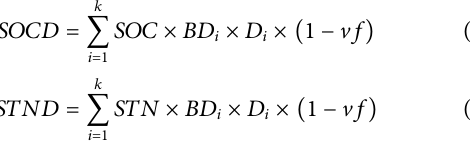
Frontiers in Environmental Science |